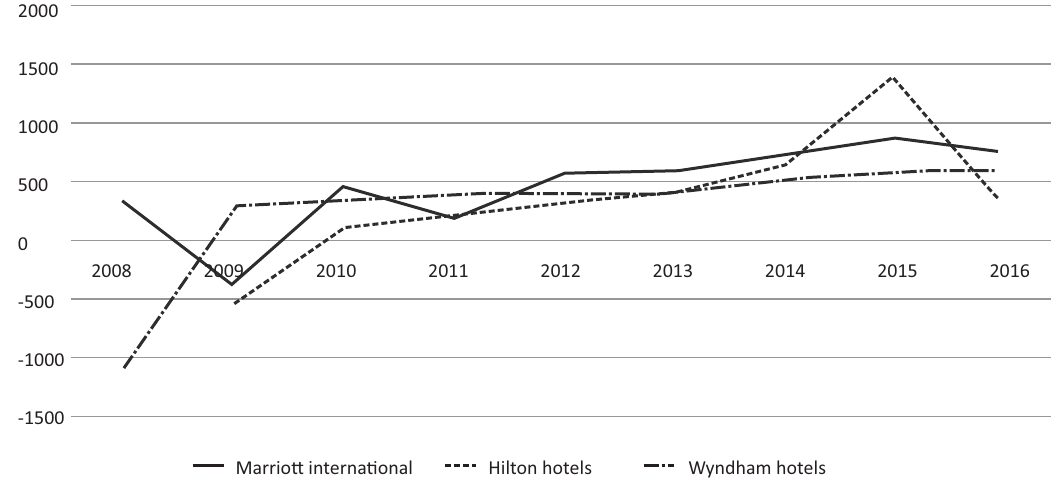
Figure 2. Dynamics of net income of hotel chains, USD mln